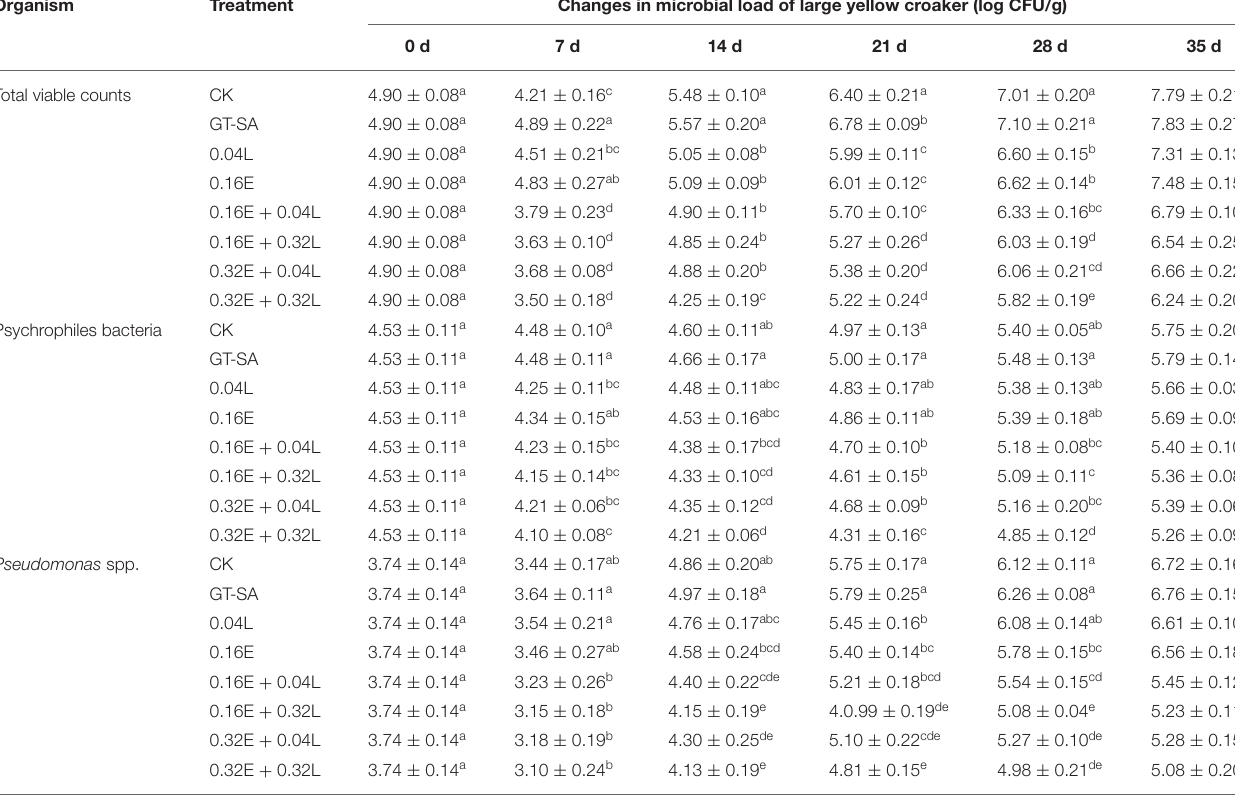
TABLE 2 | Changes in microbial load of large yellow croaker samples during superchilling storage.